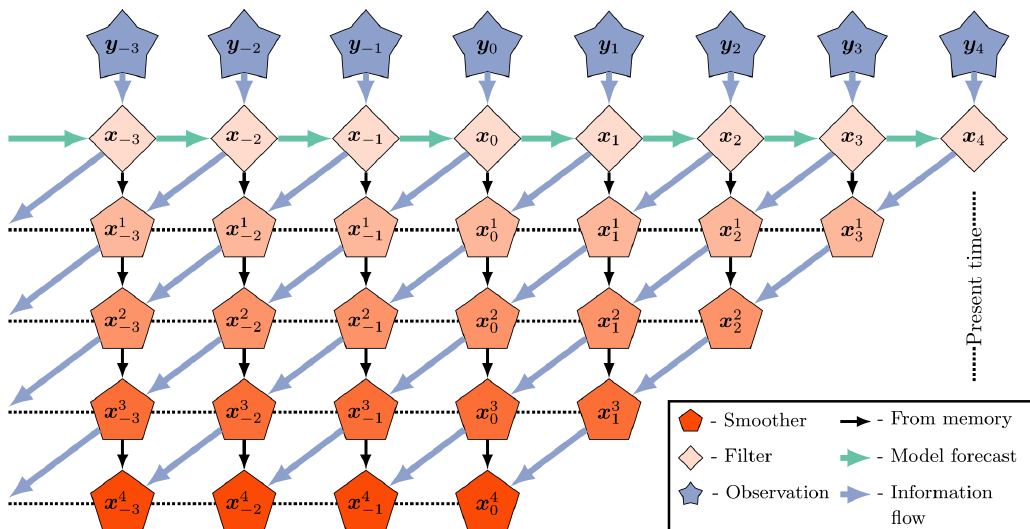
Figure 2. The EnKS with a lag = 4 and a shift = 1. The observations are assimilated sequentially via the filter cost function, and a ret- rospective reanalysis is applied to all ensemble states within the lag window stored in memory. This figure is adapted from Asch et al.